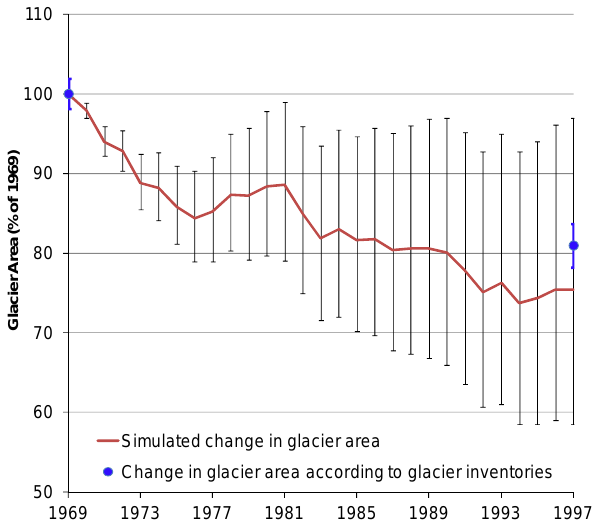
Fig. 8. Simulated change in total glacier area in Austria in the European Alps between 1969 and 1997. The red line shows the simulation results when calibrated for the average of the observed mass balance during 1969-1997 in the area. Black error bars represent simulation results when calibrated for the average of the observed mass balance plus one standard deviation (positive error) and the average of the observed mass balance minus one standard deviation (negative error). Blue dots represent the observed differences in total glacier area according to glacier inventories and blue error bars indicate the error in the glacier inventories.